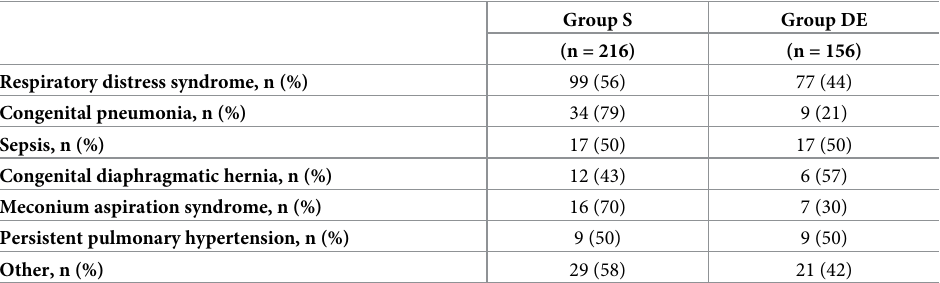
Table 5. The underlying diseases according to